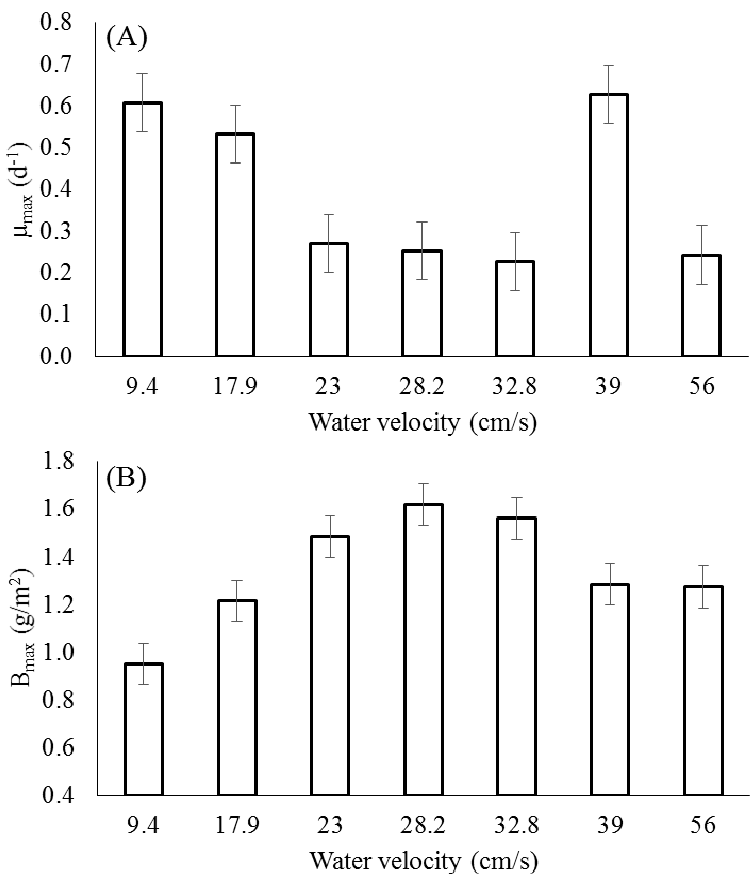
Figure 4. Effect of water velocity on ( A ) μ max and ( B ) B max of AFDM. Vertical bars represent standard deviation of replicate determinations.